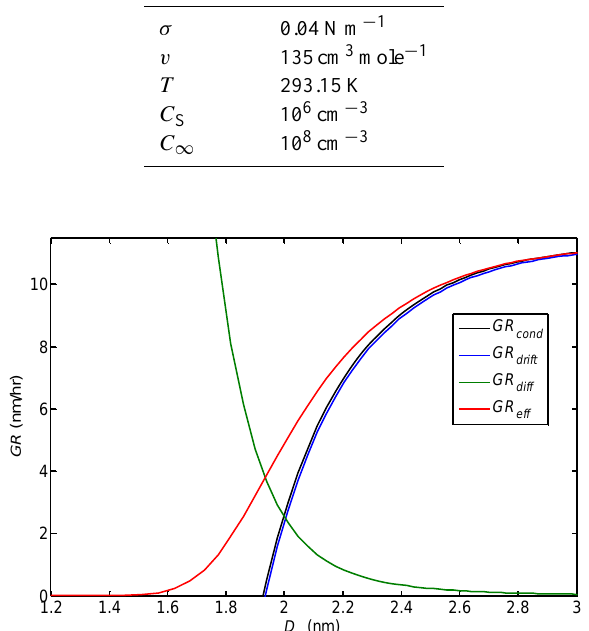
Fig. 1. Comparison of growth rates. The conventional growth rate Figure 1. Comparison of growth rates. The conventional growth rate (GR cond ) based on equation 3 (GR cond ) based on Eq. (1), the effective growth rate (GR eff ) , and (1), the effective growth rate (GR eff ), and the contributions to GR eff due to drift (GR drift ) and 4 the contributions to GR eff due to drift (GR drift ) and diffusion in diffusion in cluster size space (GR diff ) as functions of cluster size. GR cond and GR drift vanish at 5 cluster size space (GR diff ) as functions of cluster size. GR cond and the Kelvin diameter, and the difference between GR eff (red) and GR cond (black) is essentially the 6 GR drift vanish at the Kelvin diameter, and the difference between contribution from diffusion GR diff (green). All growth rates are derived using the parameters 7 GR eff (red) and GR cond (black) is essentially the contribution from listed in Table 1. 8 diffusion GR diff (green). All growth rates are derived using the pa- rameters listed in Table 1.